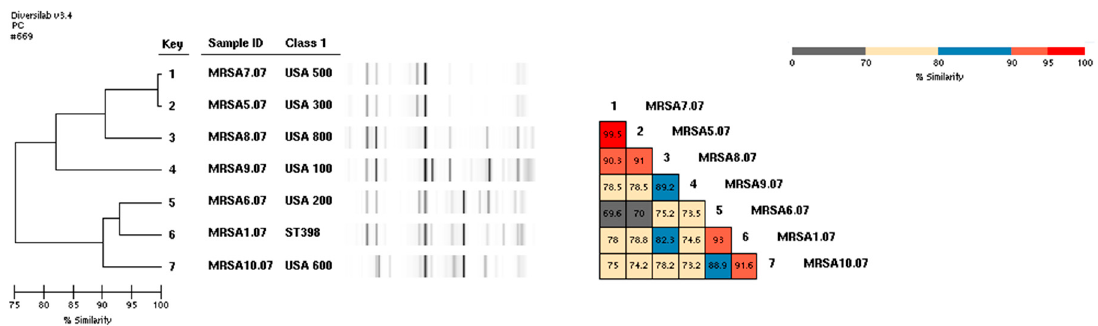
Figure 1. Distribution of methicillin-resistant Staphylococcus aureus (MRSA) isolates in North Carolina (NC) counties from active case findings at Vidant Medical Center (VMC) in February of 2007, 2008, and 2009. ( A ) All patient discharges by county. ( B ) All MRSA positives by county. ( C ) Non-matched rep-PCR MRSA positives by county. ( D ) RR (relative risk) of NM-MRSA compared to typable-MRSA from SaTScan Poisson Cluster detection analysis. These results are underlaid with pig density from 2007.